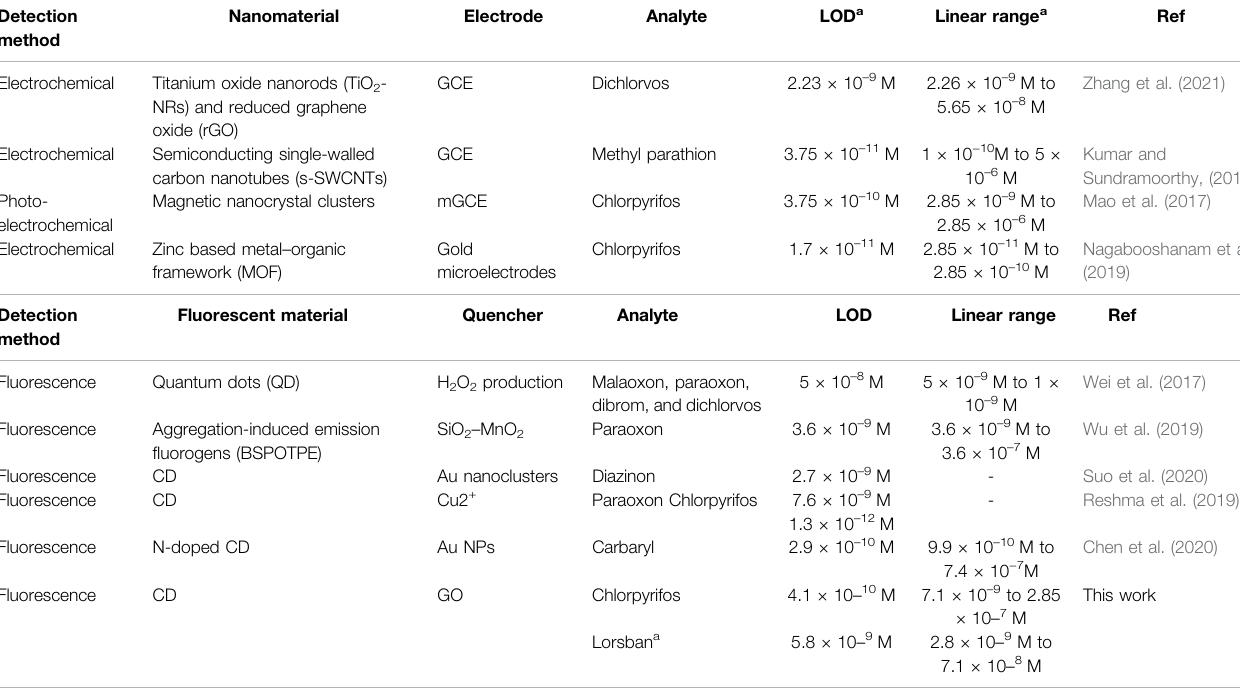
TABLE 1 | Comparison of the present method with other reported highly sensitive electrochemical and fl uorescence methods based on AChE and nanomaterials for organophosphate pesticide (OP)